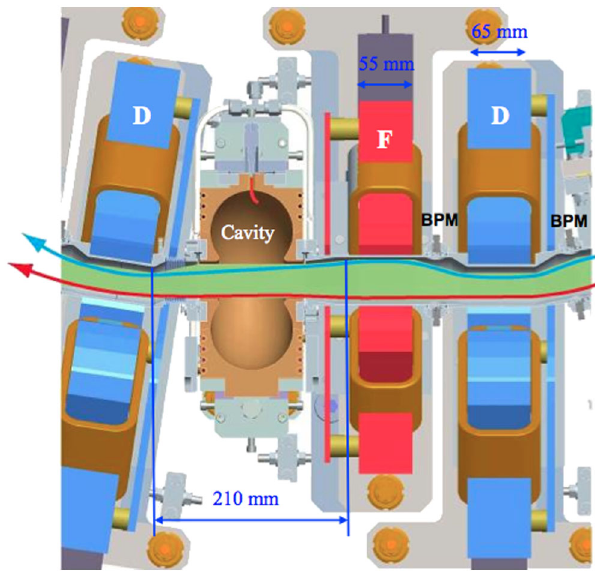
FIG. 1. Schematic of an EMMA cell showing a D (blue) and F (red) quadrupole doublet, rf cavity, and BPMs (dark gray). The blue and red arrows indicate the paths taken by the low and high momentum electrons,